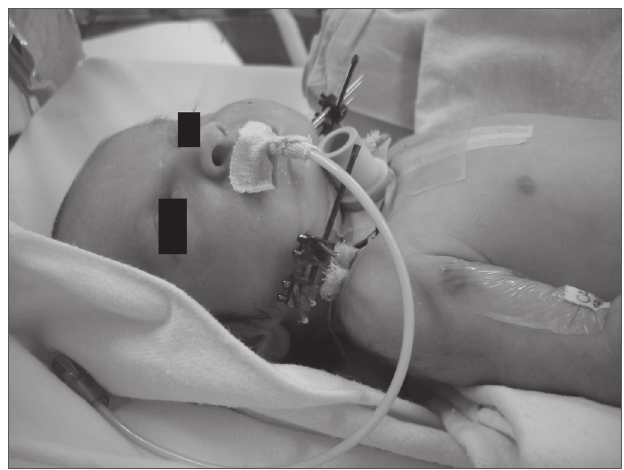
Figura 1. Recém-nascido com sequência de Pierre Robin operado aos quatro dias de vida: traqueostomia e osteotomia mandibular bila- teral com colocação de distrator externo. Note a presença de sonda orogástrica como via alternativa de